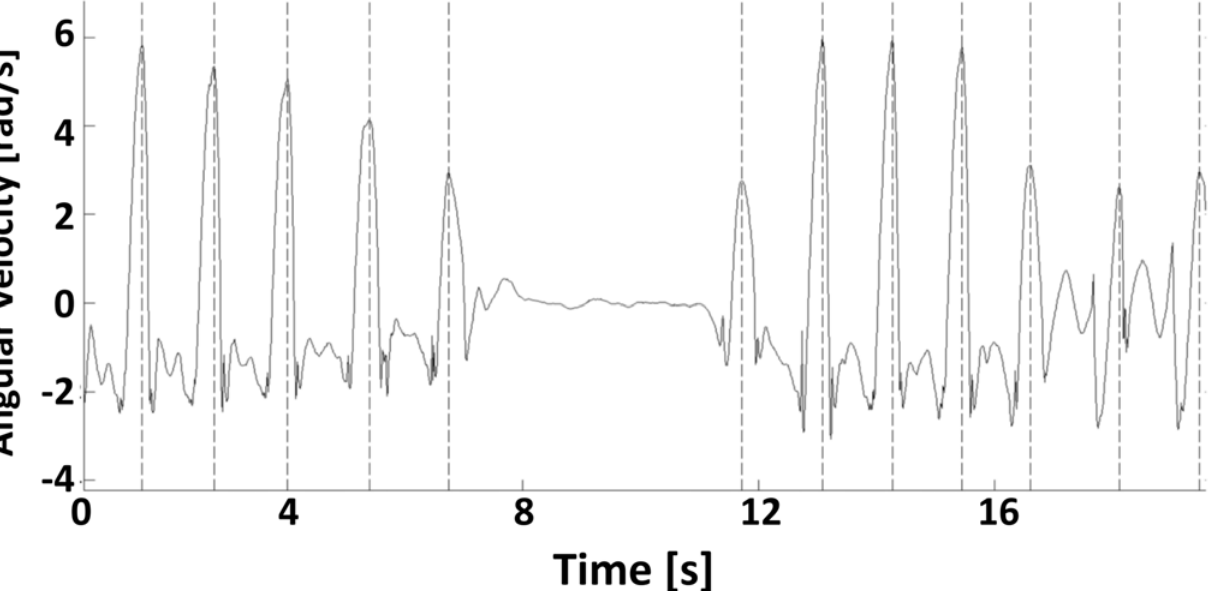
Fig 2. Typical angular velocity signal of the shank in the sagittal plane during consecutive steps. The figure shows the angular velocity signal as measured by one of the shank sensors in the sagittal plane during a portion of a randomly selected indoor walking trial. The shown portion of the signal includes walking, stopping and turning. The maxima detected by the algorithm used to detect single steps are also highlighted (dotted vertical